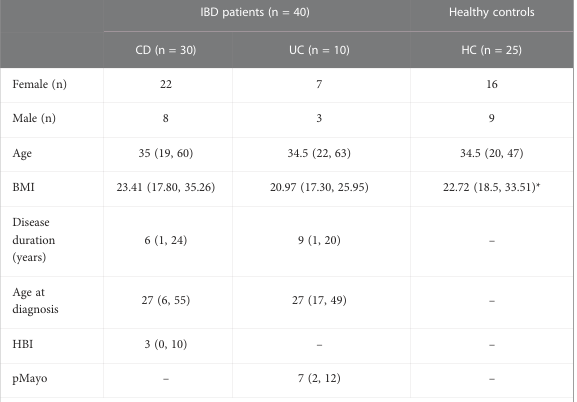
The values are shown as median with the minimum and maximum values in parentheses. Fisher exact test was used to compare the distribution of a gender nominal variables between IBD patients and HC. Mixed-effect analysis with Tukey ’ s multiple comparisons test was used to determine differences in Age or BMI between IBD patients and HC. n, number of participants; BMI, body mass index; HBI, Harvey-Bradshaw index; pMayo (partial Mayo score); ns, not signi fi cant;*(UC vs. HC);